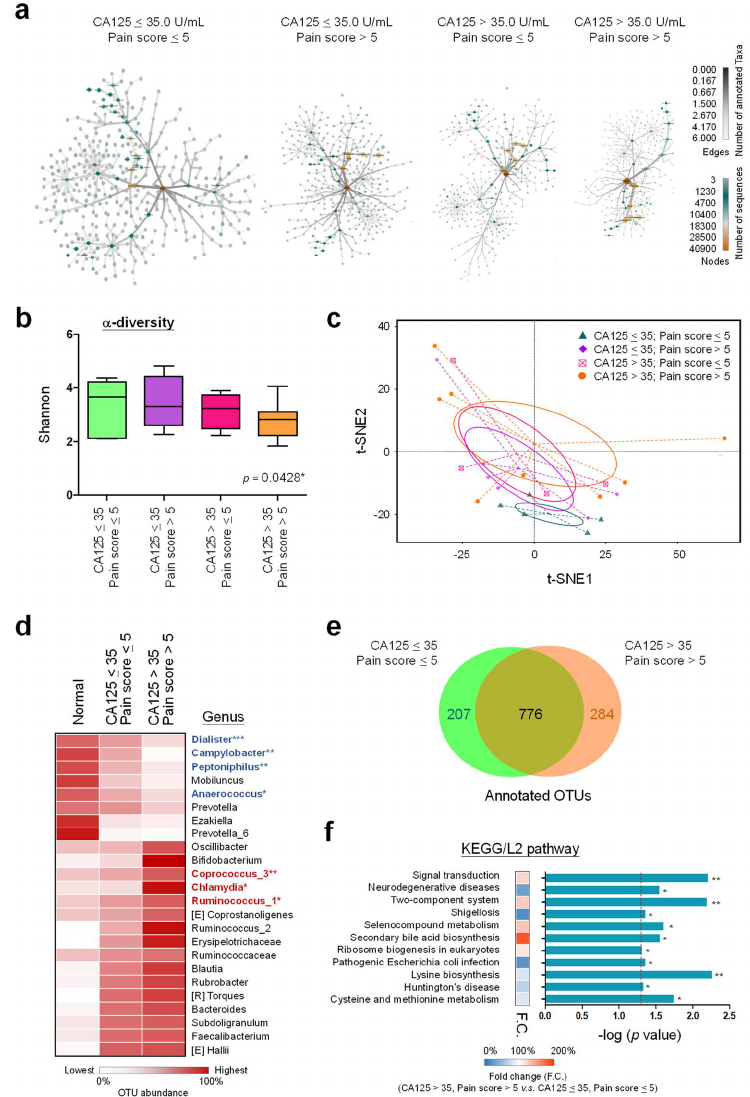
Figure 5. Community diversity of cervical microbiome in endometriosis patients correlate with the severity of clinical outcomes. ( a ) The community diversity in each patient group is revealed by a heat tree map, showing the taxonomic context from higher ranks in the center to lower ranks in peripheries (Kingdom to Species). The abundance of microbiotas in each community can be quantified and visualized by color and size of the nodes and edges. ( b ) The box-plot was generated to illustrate alpha diversity indices (Shannon diversity) in cervical microbiomes of patient groups with different levels of severities. The statistic for the linear trend is estimated by one-way ANOVA. ( c ) The t-SNE analysis diagram was plotted to calculate the actual and embedded distance among the patient groups with different levels of severities. ( d ) The heatmap indicates the average counts of genera that show consistently up-regulated or down-regulated among normal women, double-negative and double-positive patients. Genera with bold font show statistically significant differences in OTU abundance among the groups by one-way ANOVA (Figure S2). ( e ) The Venn diagram indicates annotated OTUs in each group. Values in the overlapping part represent common OTUs. The others are specific OTUs in each group. ( f ) The KEGG/L2 pathways that show significant fold changes between double-positive and double-negative patients are presented. Statistical significance: *, p < 0.05; **, p < 0.01, ***, p <